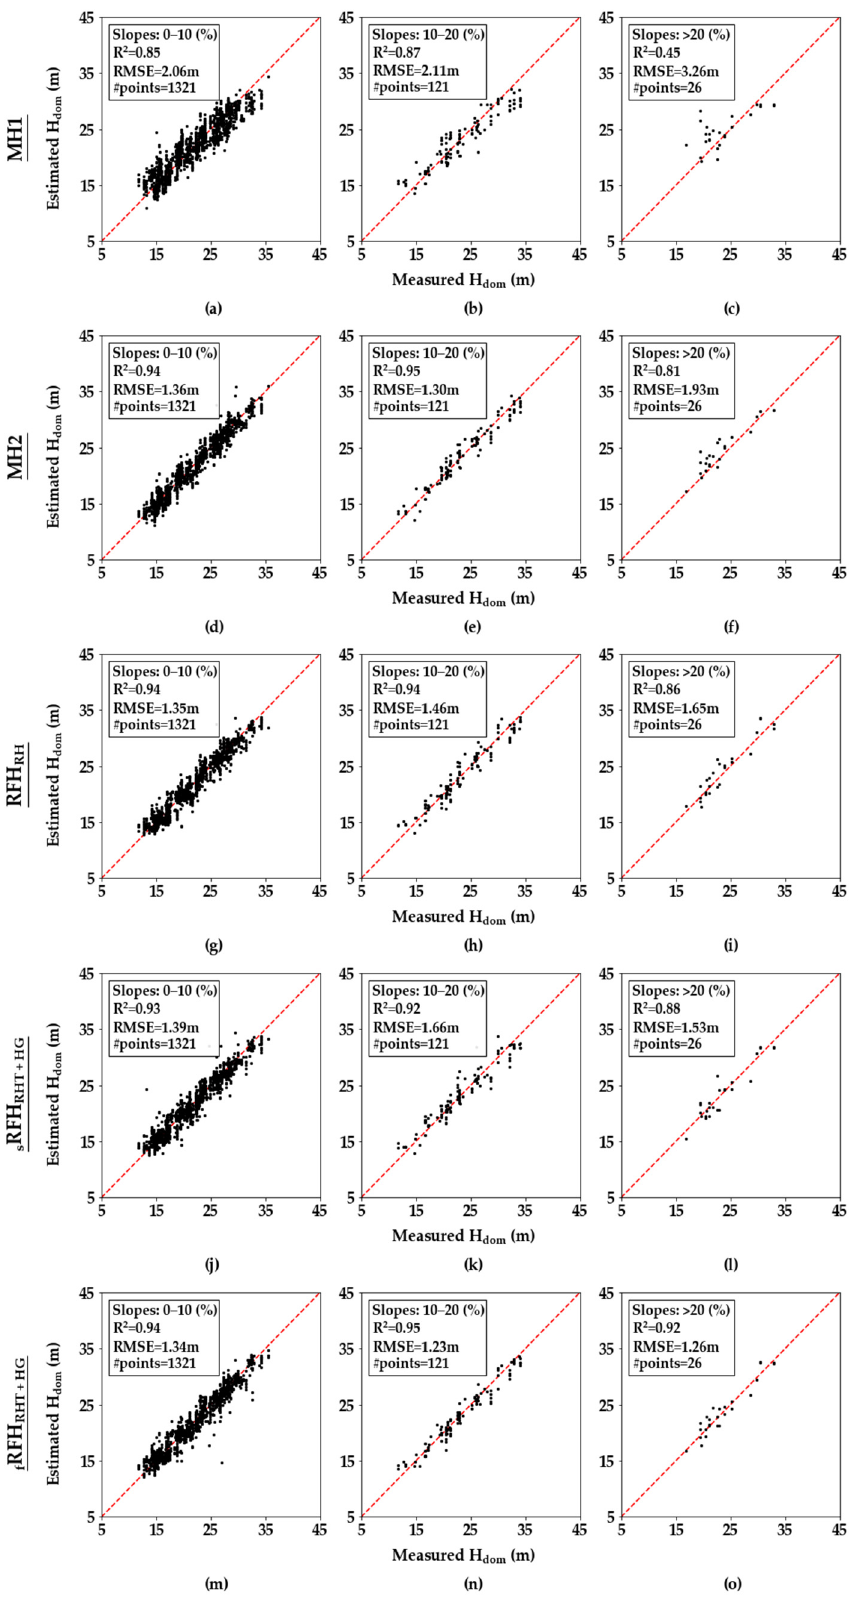
Figure 7. ( a – o ) Comparison of the measured vs. estimated dominant height from the models presented in Section 3.1 (Table 2) using GEDI metrics extracted with the processing configuration “a1” of GEDI data.